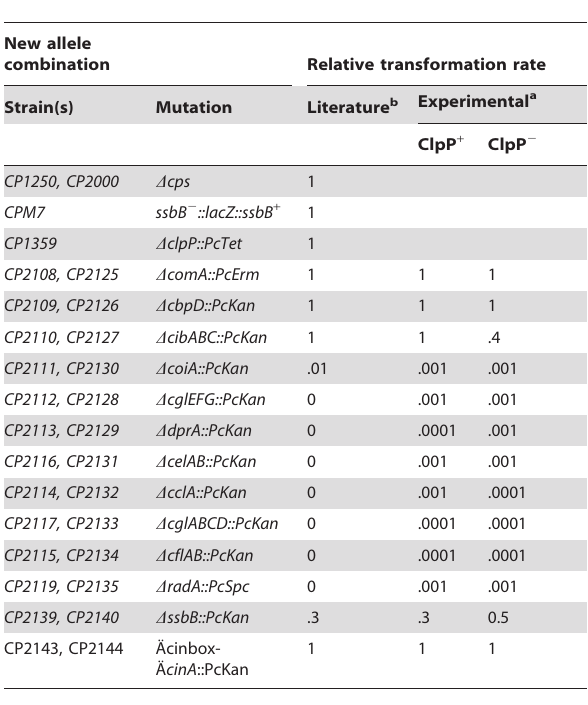
Table 4. Comparison of transformation efficiency of new strains with